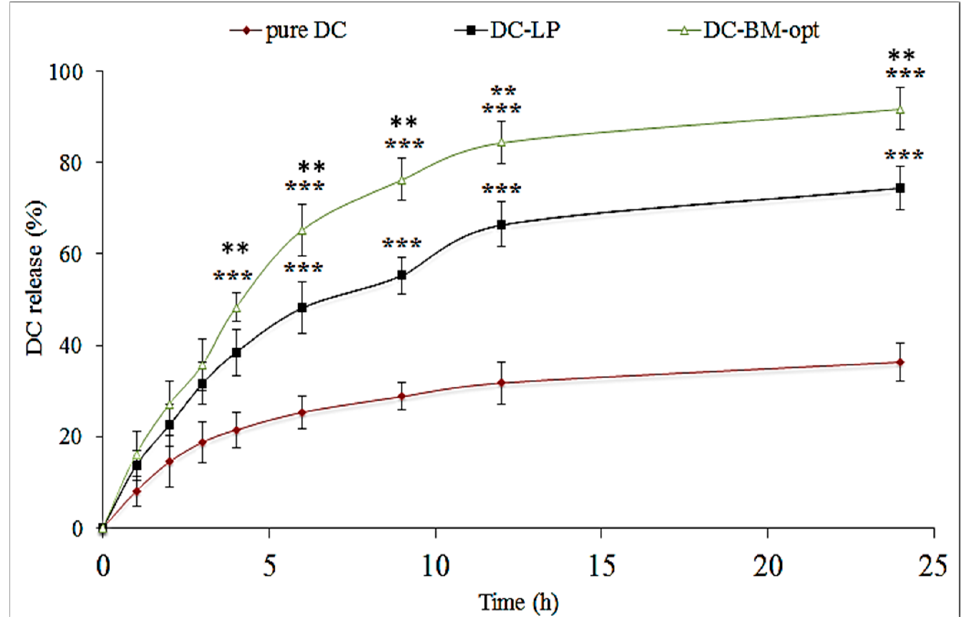
Figure 5. Release study of different treatment groups (pure diclofenac (DC), optimized diclofenac bilosomes (DC-BMs-opt), and diclofenac liposomes (DC-LP)). Study was performed in triplicate and data are shown as mean ± SD. Statistical analysis performed between each group and p < 0.05 considered significant. *** highly significant to pure DC; ** significant to pure DC-LP.